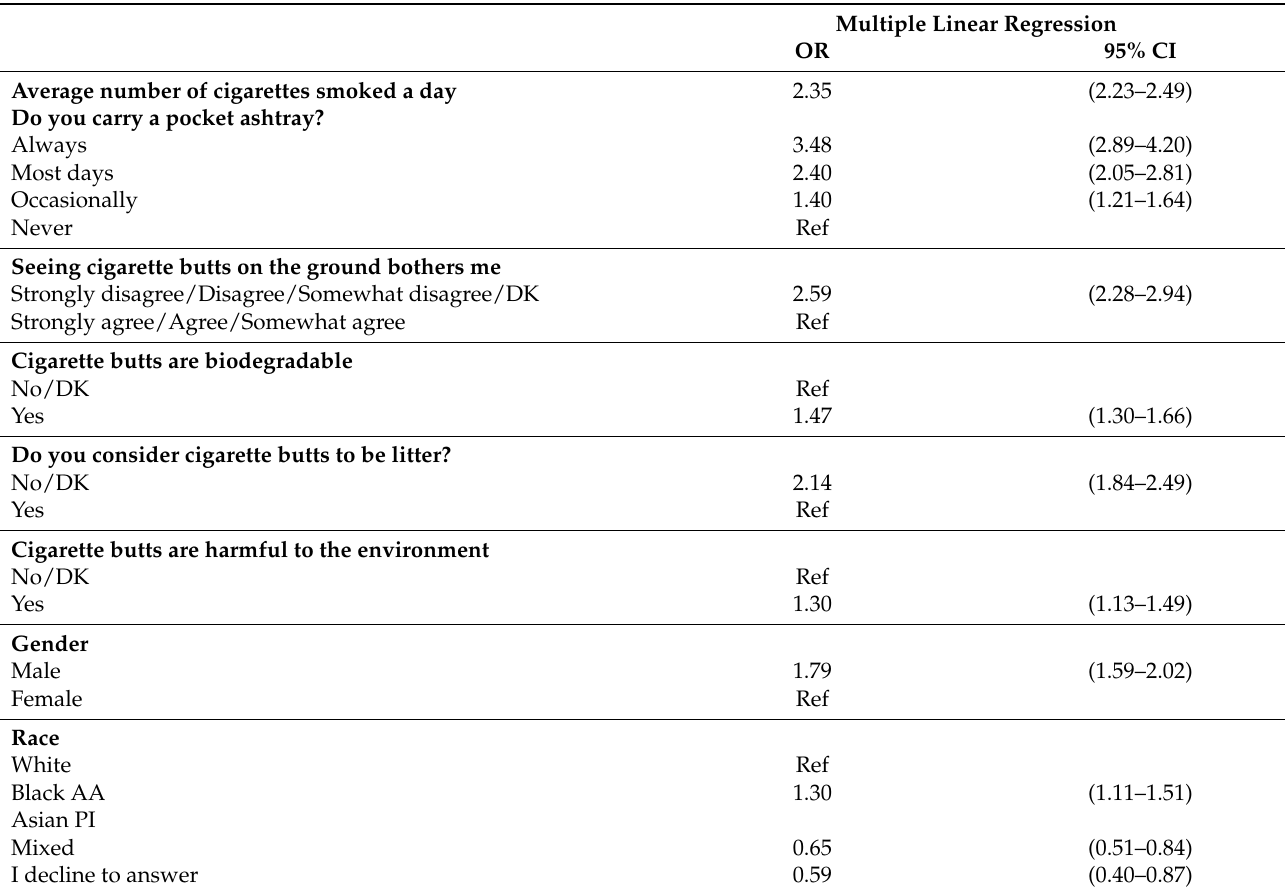
Table 6. Statistically significant predictors of number of cigarette butts littered † in past 24 h among college-age smokers ( n = 7532, p <